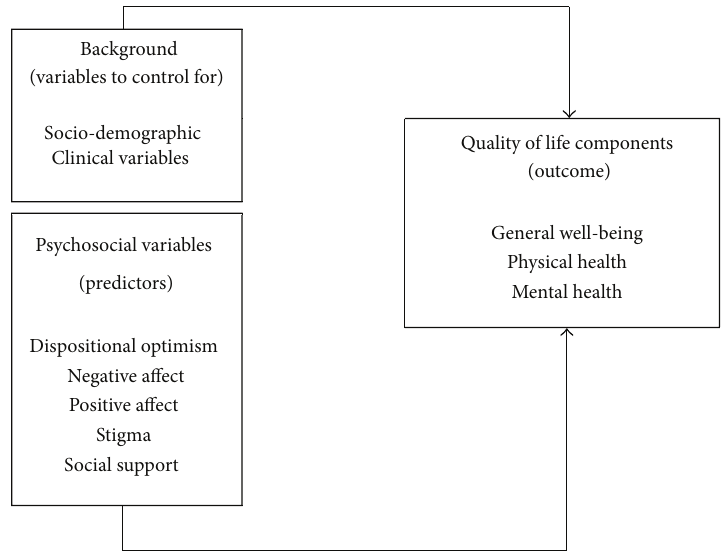
Figure 1: Conceptual model of sociodemographic, clinical, and psychosocial factors influencing